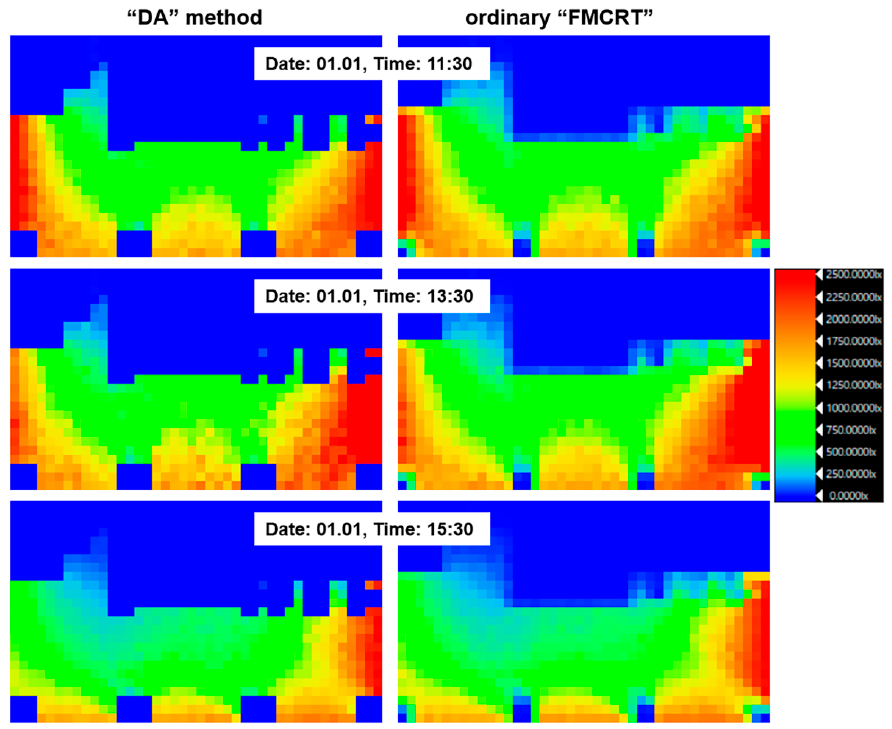
Figure 6. Illuminance distribution for the third verification scene calculated by our (“DA”) method and by FMCRT.